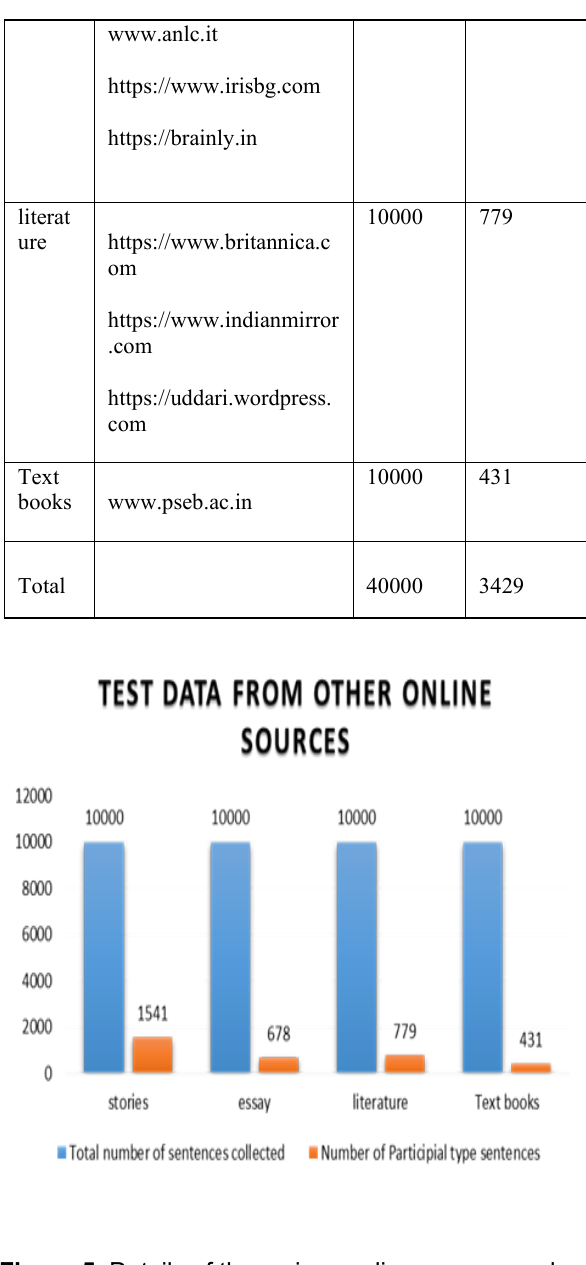
Figure 5. Details of the various online corpus used for